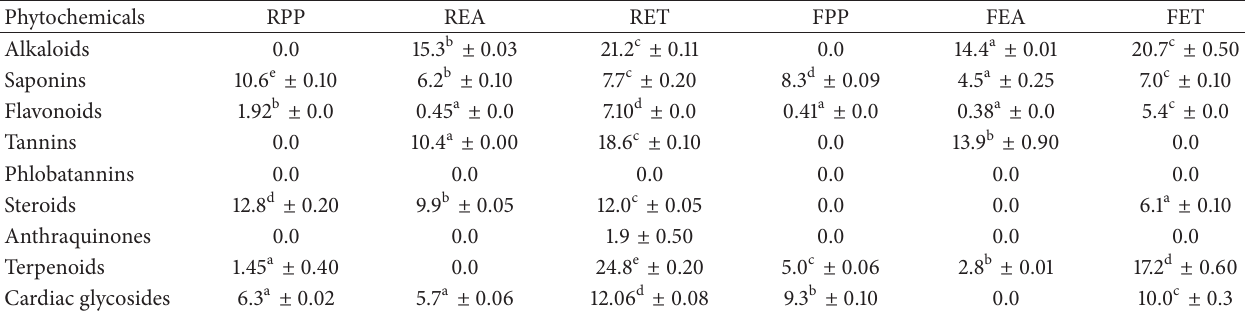
Table 1: Phytochemical constituents (mg/g) of extracts from Lenzites quercina .